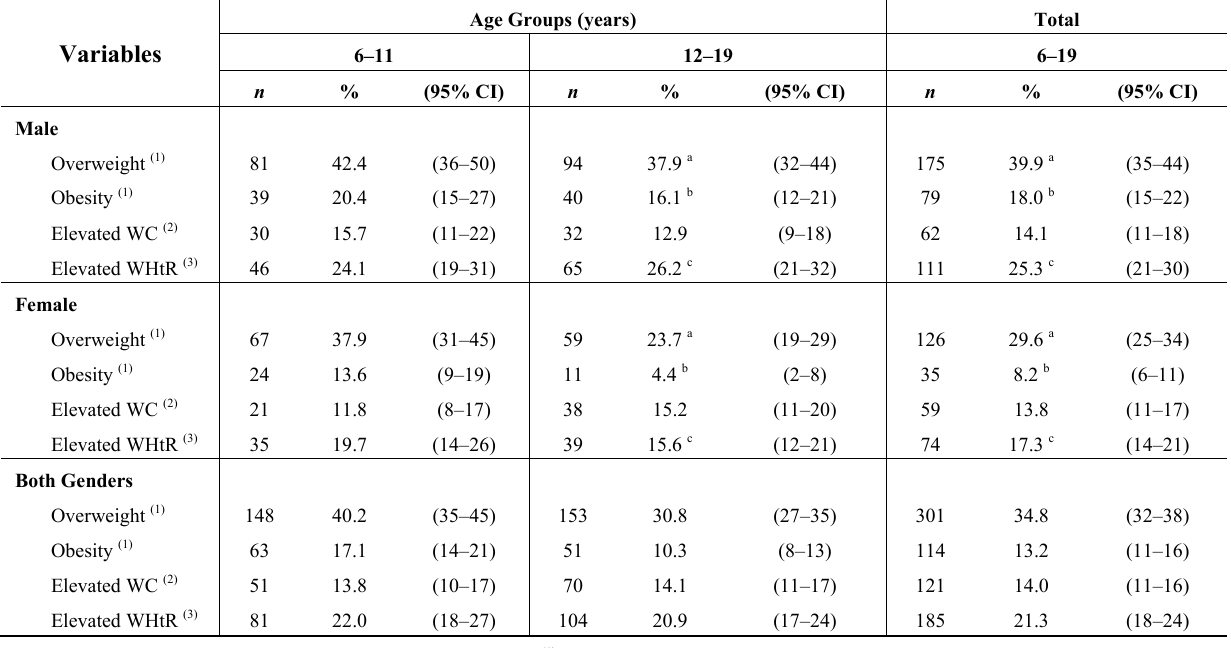
Table 2. Prevalence of overweight, obesity and abdominal adiposity amongst Lebanese children and adolescents ( n = 868) by gender and by age